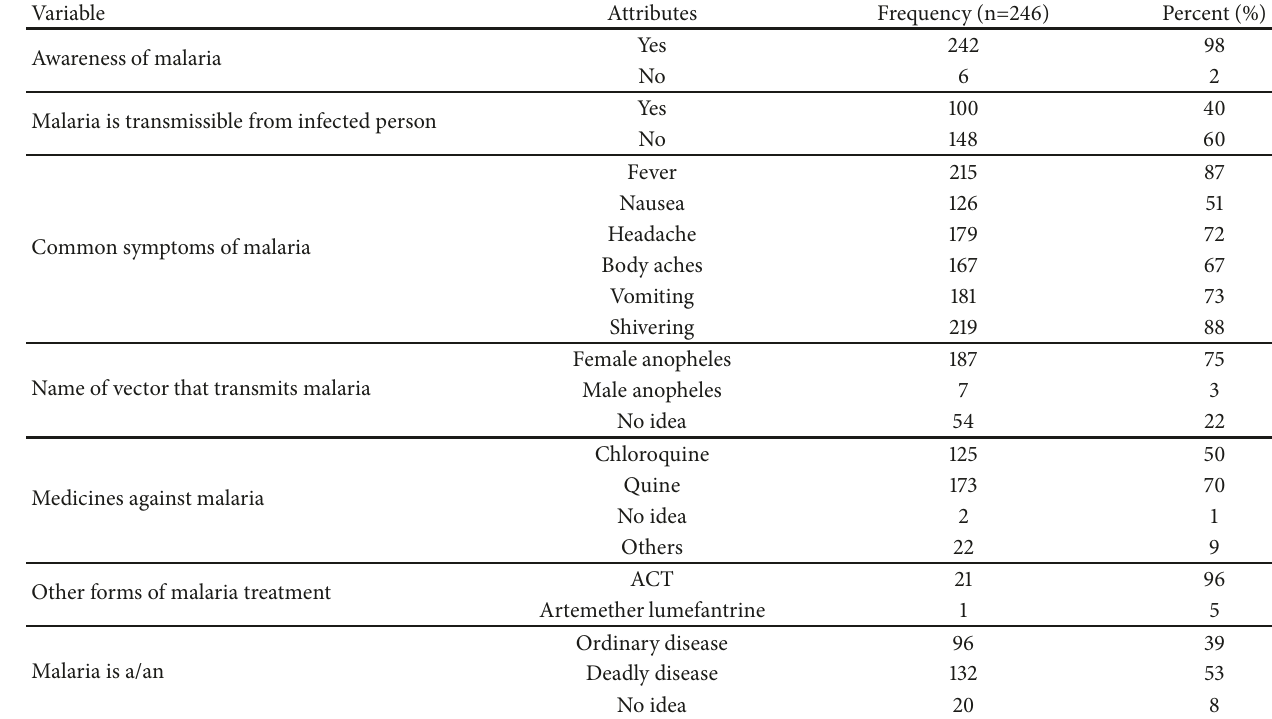
Table 2: Awareness on malaria spread, symptoms, and